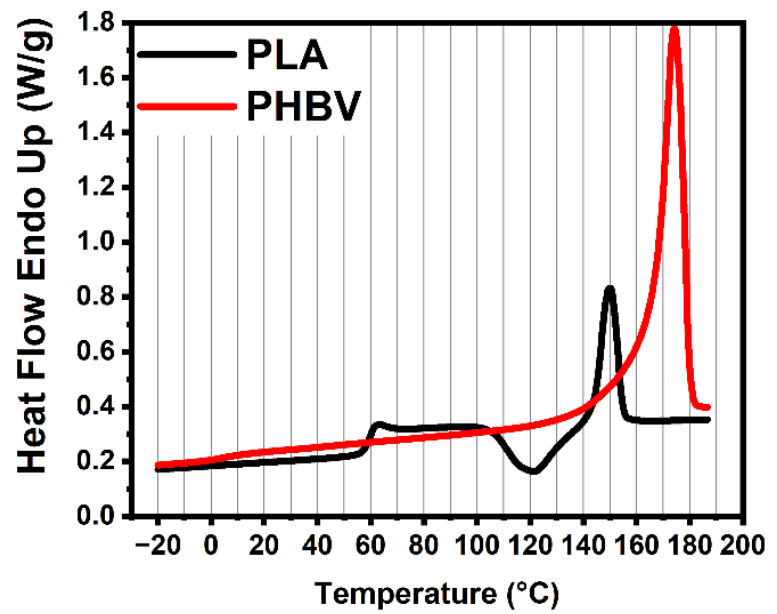
Figure 3. Results from DSC of neat PLA and PHBV. Table 2. Results from DSC and TGA of neat PLA and PHBV.